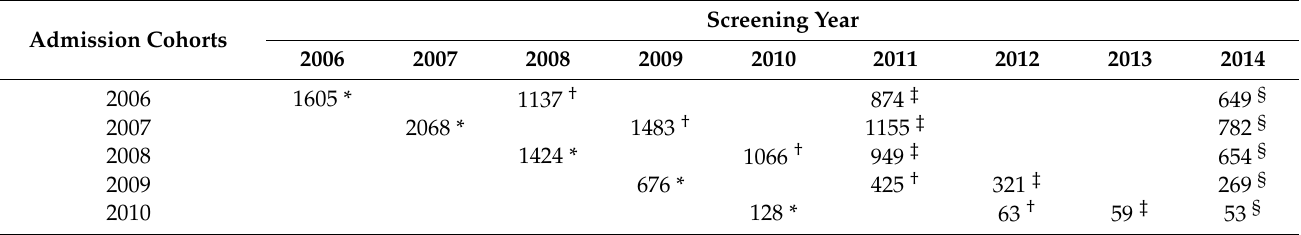
Table 1. Enrollment and retention situations during 2006–2014 for 5 admission cohorts in the “Landseed Integrated Outreaching Neighborhood Screening (LIONS)”